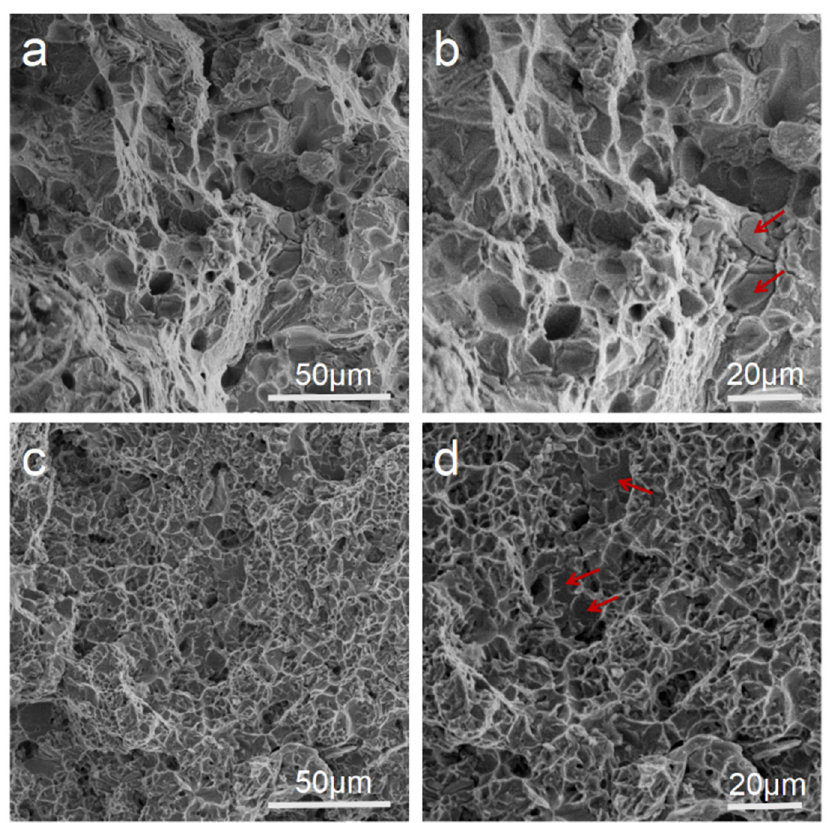
Figure 14. SEM images of the tensile fracture surface of the Ti-30Mo-0.5TiC-xZr alloys tested at 600 °C: ( a ) low magnification of T0, ( b ) high magnification of T0, ( c ) low magnification of T4Z, and ( d ) high magnification of T4Z.